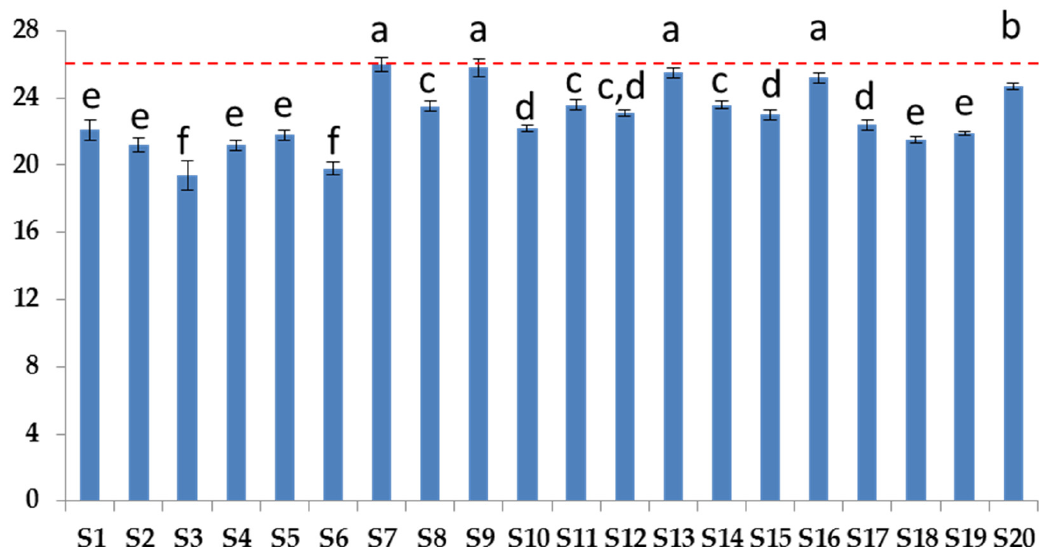
Figure 8. Totox values of supplements (red dotted line indicates the GOED maximum limit of 26). Different letters report statistical differences ( p < 0.05).